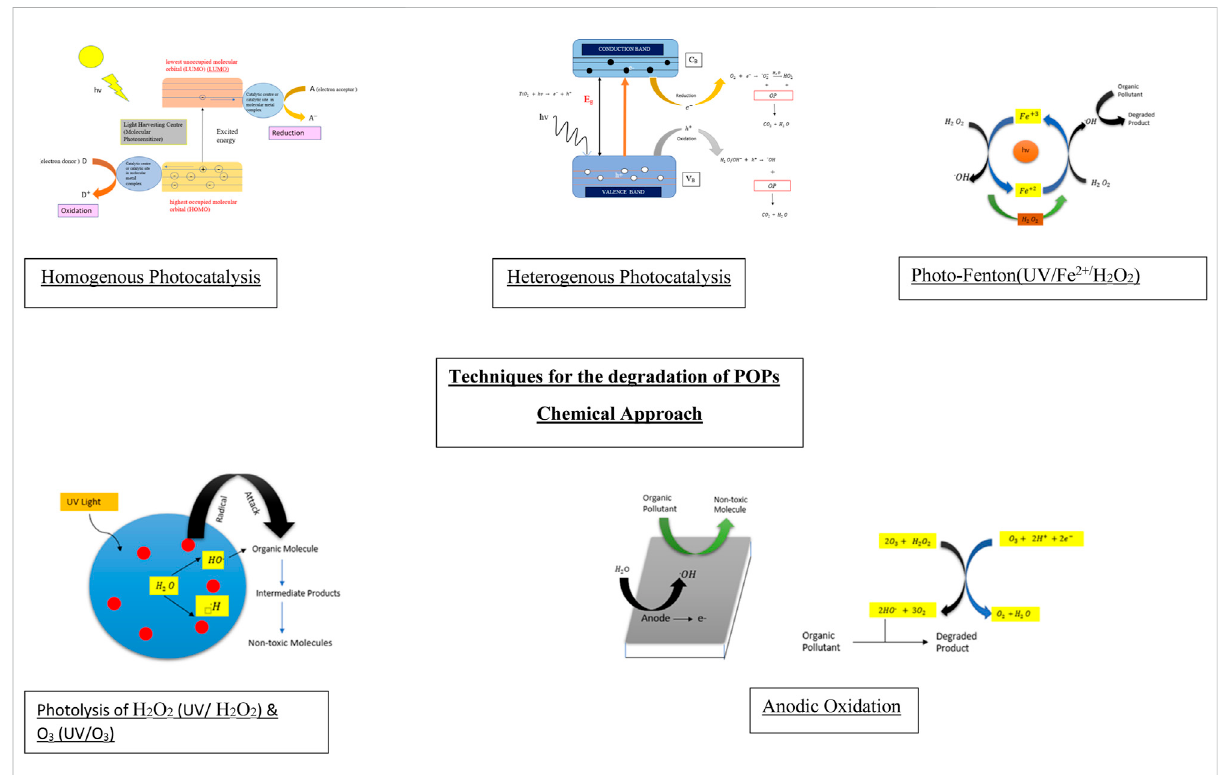
FIGURE 2 Chemical techniques used for the degradation of persistent organic